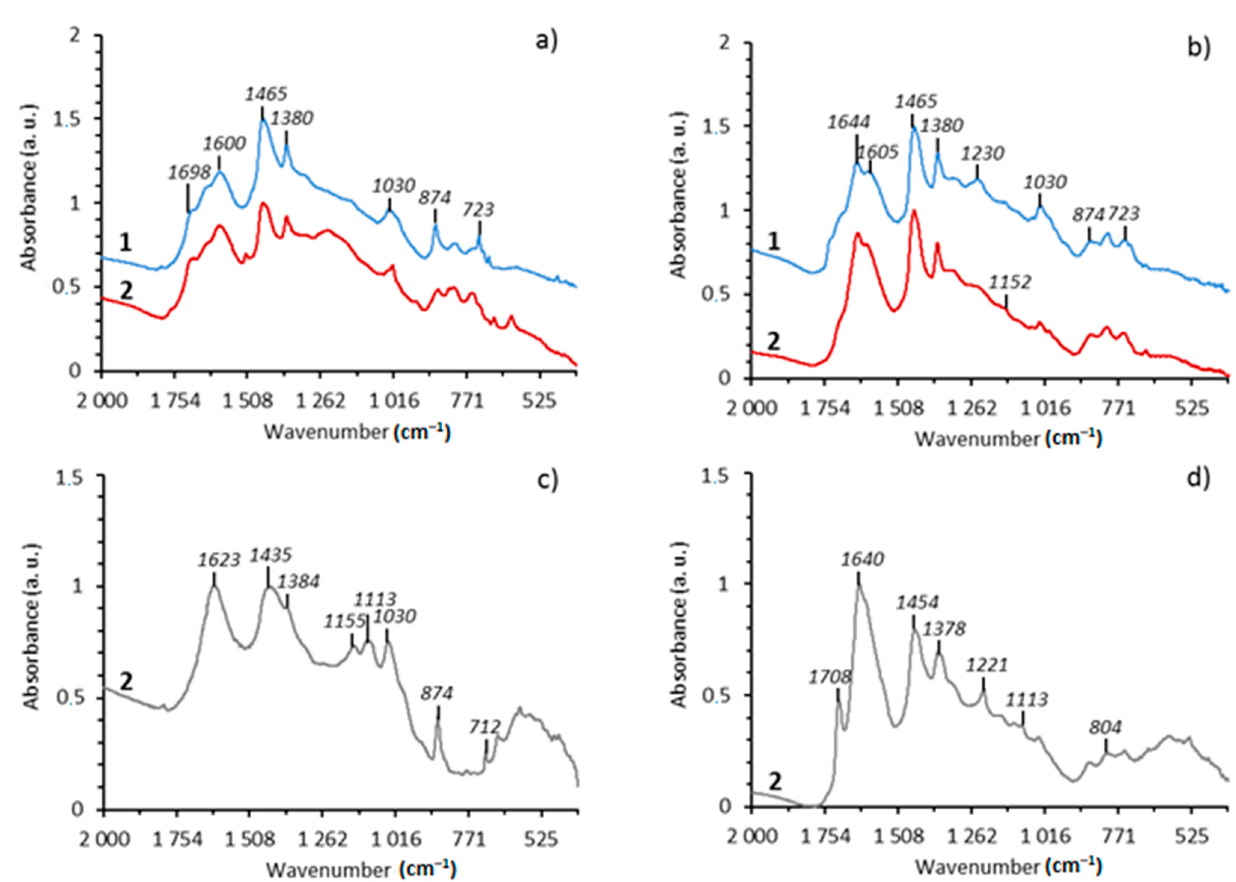
Figure 1. IR specters of asphaltenes ( a , b ) and carbene-carboids ( c , d ) from the rocks of the Zelenogorskaya and Berezovskaya areas before and after the experiments: 1—initial rock, 2—experiment at 350 ° С .